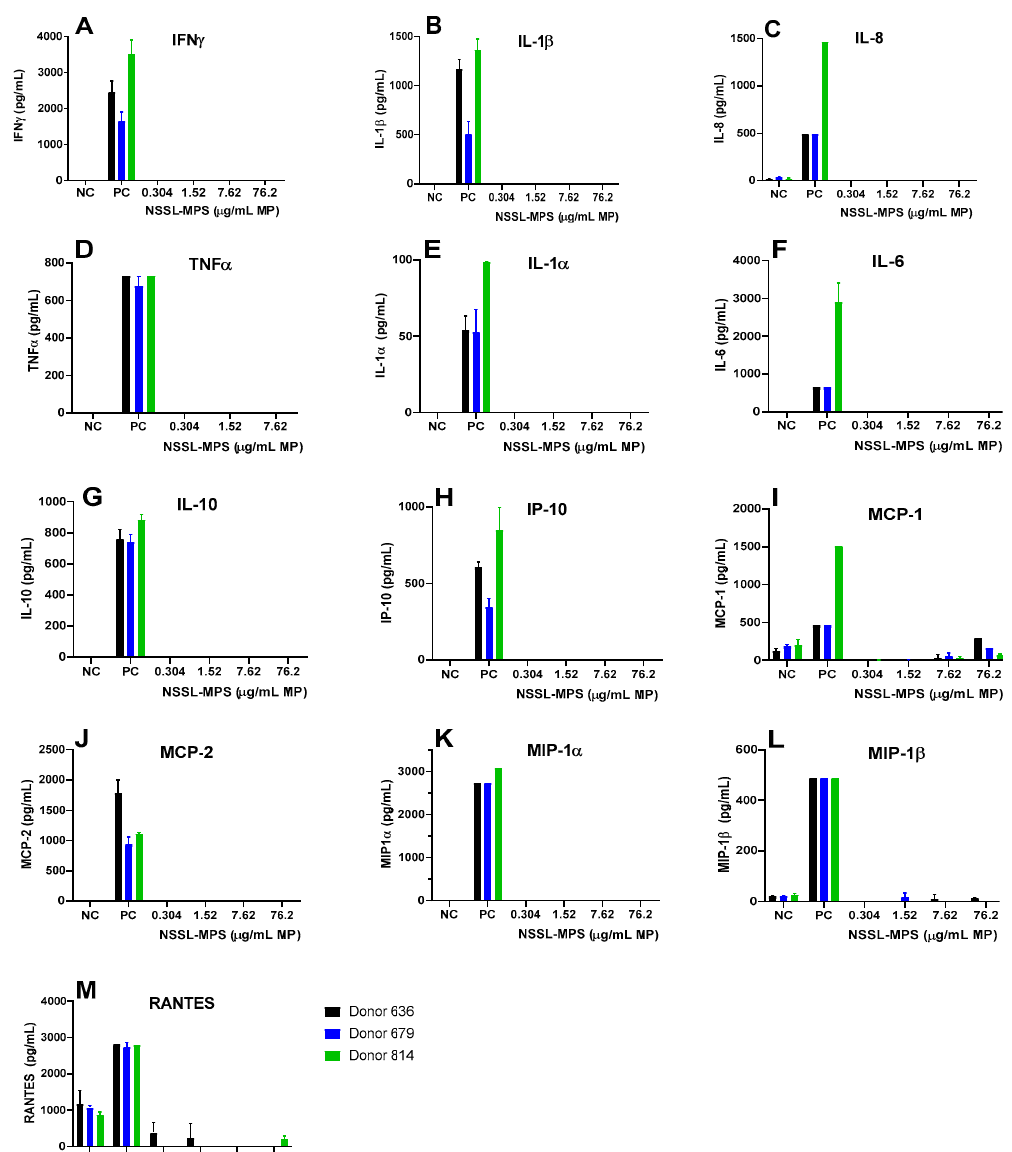
Figure 2. Individual cytokines/chemokines/interferon release tests in the presence of the NSSL-MPS formulation. NSSL-MPS at different concentrations (0.304, 1.52, 7.62 or 76.2 µg/mL MP) were incubated for 24 h in whole human blood from at least 3 different healthy donors. After incubation, the supernatant was tested for each relevant signaling molecule with a corresponding ELISA assay. NC, Negative Control; PC, Positive Control, 20 ng/mL of E.coli K12 LPS .